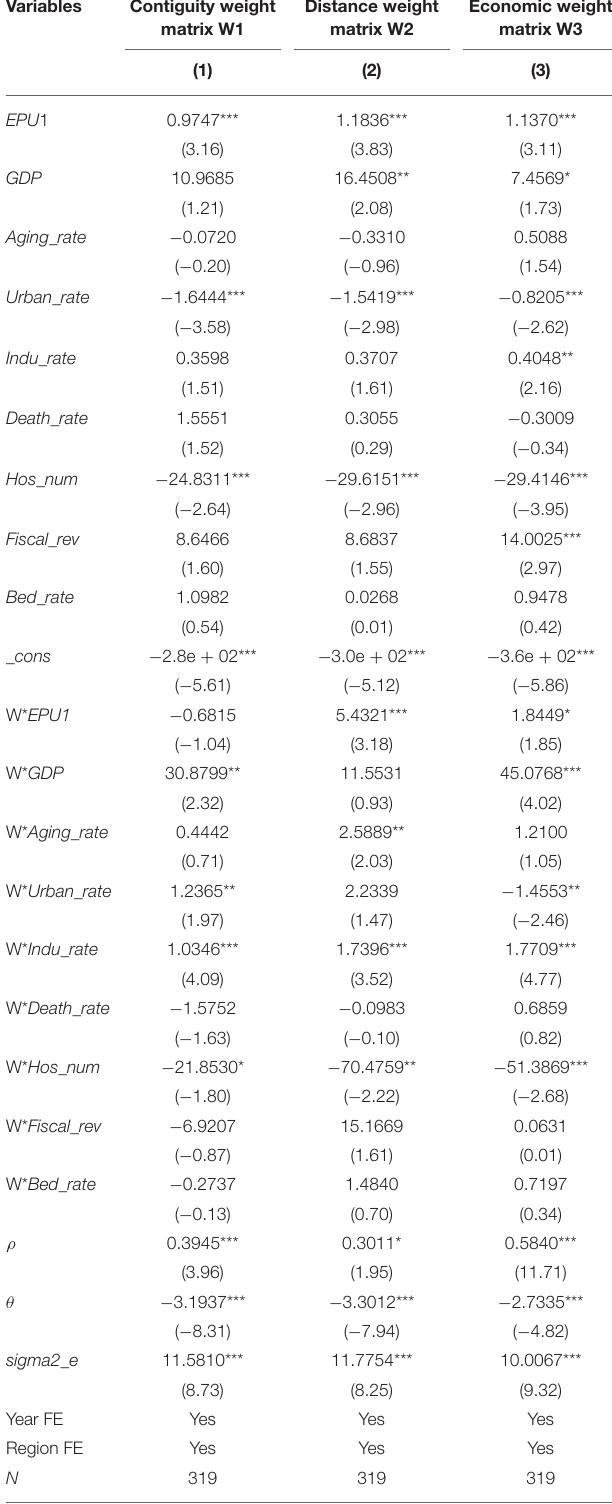
TABLE 5 | Estimation results of the impact of EPU on healthcare expenditure.